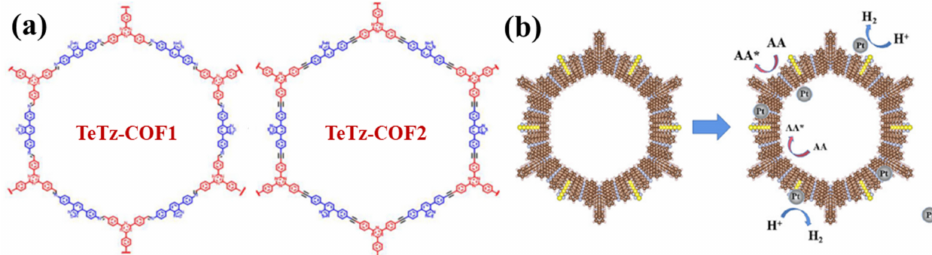
Figure 6. ( a ) Highly similar structures of TeTz-COF1 and TeTz-COF2. ( b ) Mechanism of photocatalytic HER of TeTZ–COFs. Reproduced with permission from Ref. [45]. Copyright: Royal Society of Chemistry,